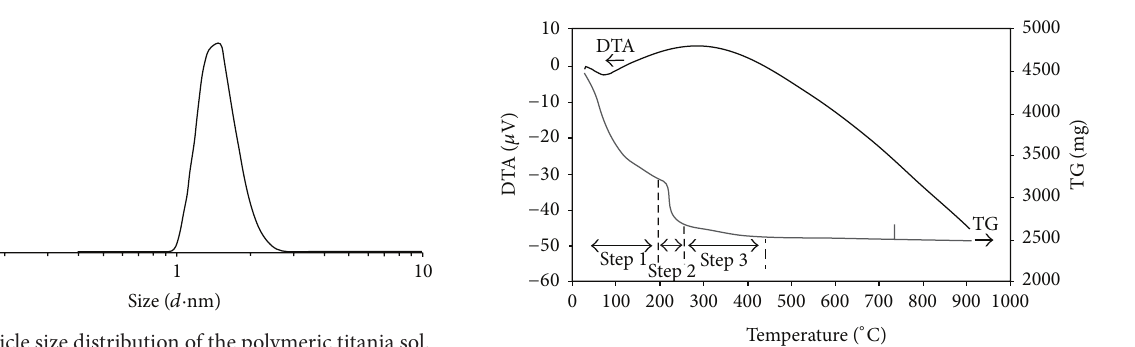
Figure 10: The thermogravimetric and DTA curves of the dried polymeric titania